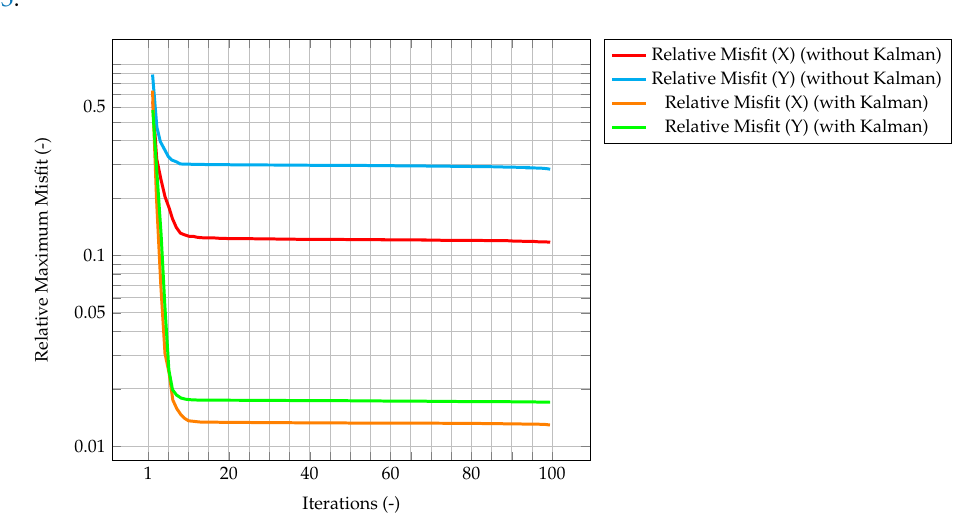
Figure 6. Time evolution of the maximum normalized misfit between observation and CFD solution. This misfit is computed as the difference between the observations (cleaned from the noise) and the CFD solution computed on the coarse grid and corrected by the Kalman filter.